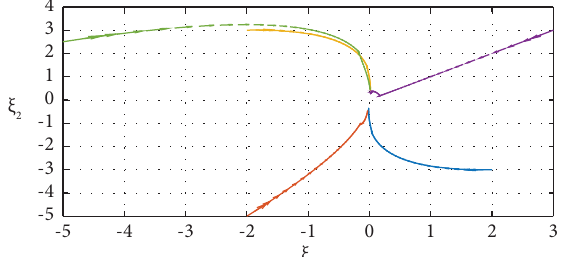
− ξ plane for Example 2 without 1 2